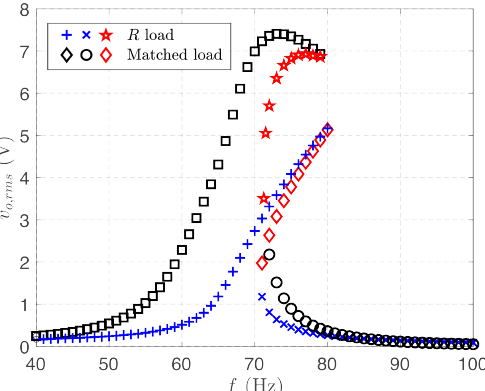
Figure 9. Root mean square value of the output voltage vs. forcing frequency for a nonlinear cantilever beam piezoelectric harvester [67]. Blue crosses, blue × and red pentagrams are for the resistive load. Black squares, black circles and red diamonds are for the matched load. Blue and black markers refer to stable limit cycles, red markers are for unstable limit